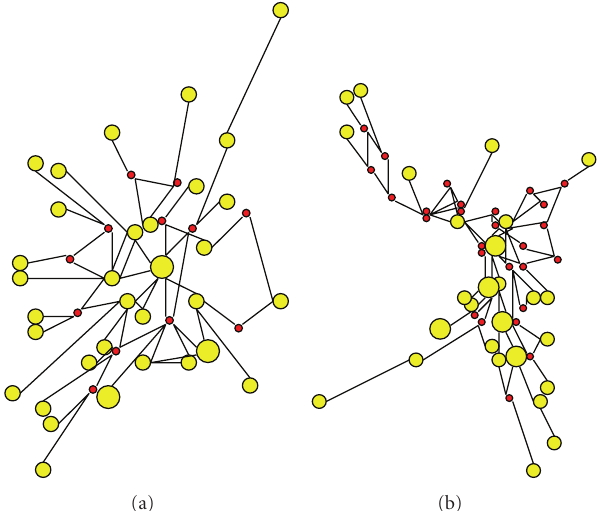
Figure 4: Phylogenetic networks of hsa-miR-548-5p (a) and hsa-miR-548-3p (b). 37 sequences of miR-548-5p and 33 sequences of miR- 548-3p are reconstructed, respectively. More median vector (red circles) are found in network of miR-548-3p.